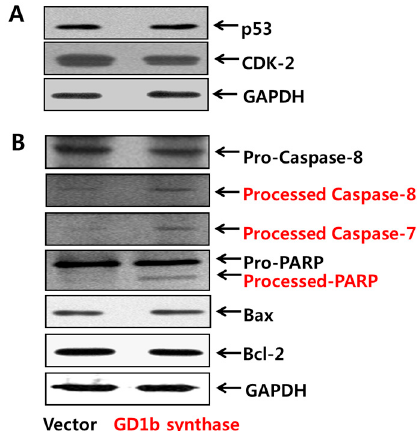
Figure 7. Effects of GD1b overexpression on cell cycle arrest and apoptosis. The cell lysates with equal protein content were subjected to SDS-PAGE and the separated proteins were analyzed by Western blotting using each antibody. Expression of cell cycle arrest- ( A ) and apoptosis- ( B ) related molecules were examined of protein extracts of Vector- and GD1b-transfectant cells. GAPDH was used as the internal control.